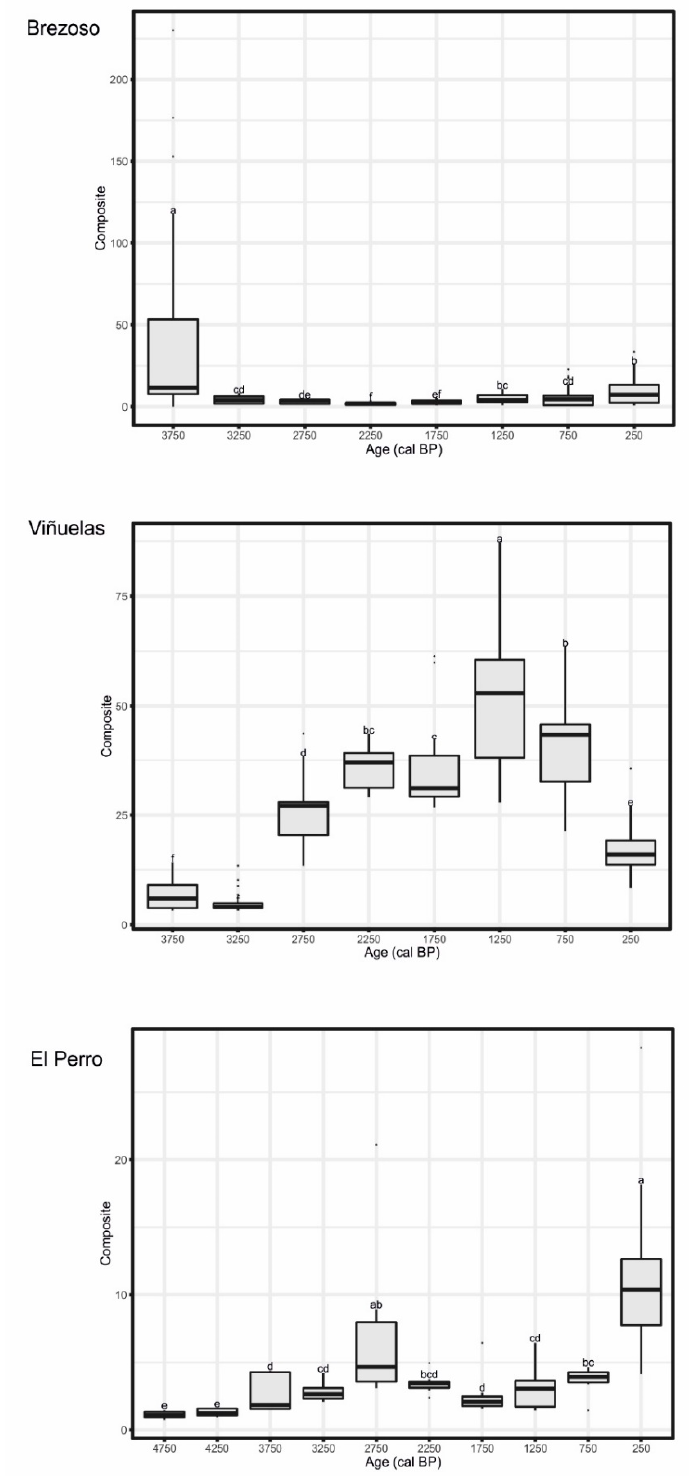
Figure A3. Kruskal–Wallis test from the studied sites.